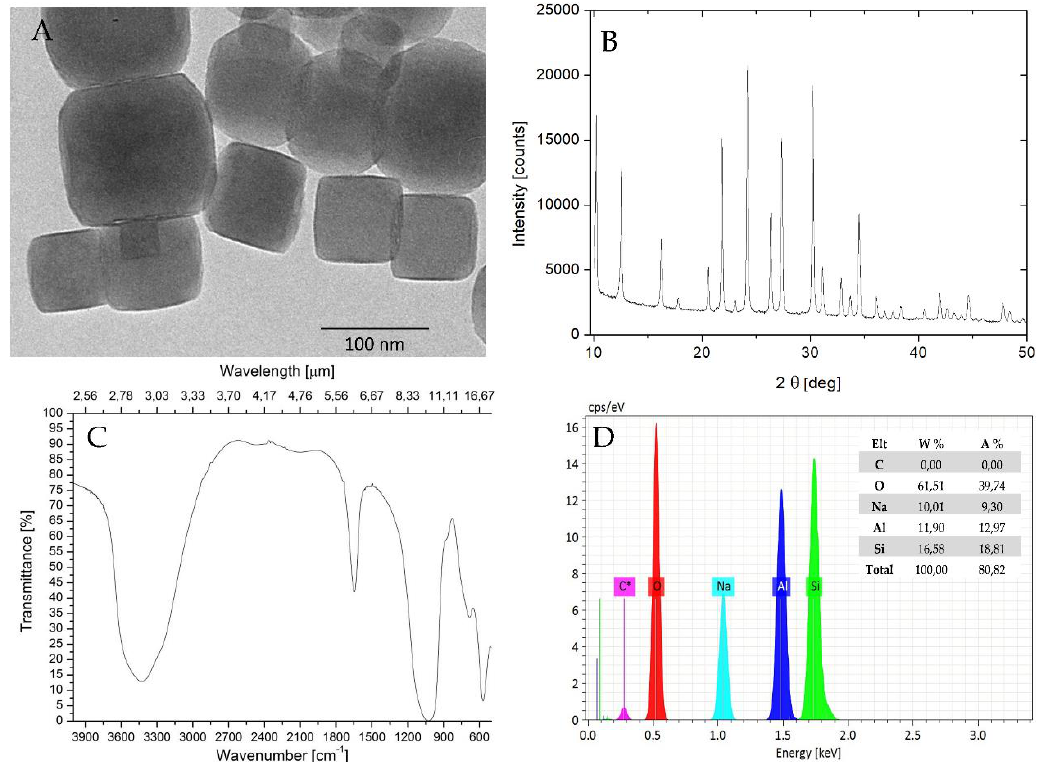
Figure 3. Physicochemical characteristics of NaA nanozeolites (sample 6). ( A ) Transmission electron microscopy analysis, ( B ) XRD analysis, ( C ) FT-IR spectra, ( D ) EDS analysis.